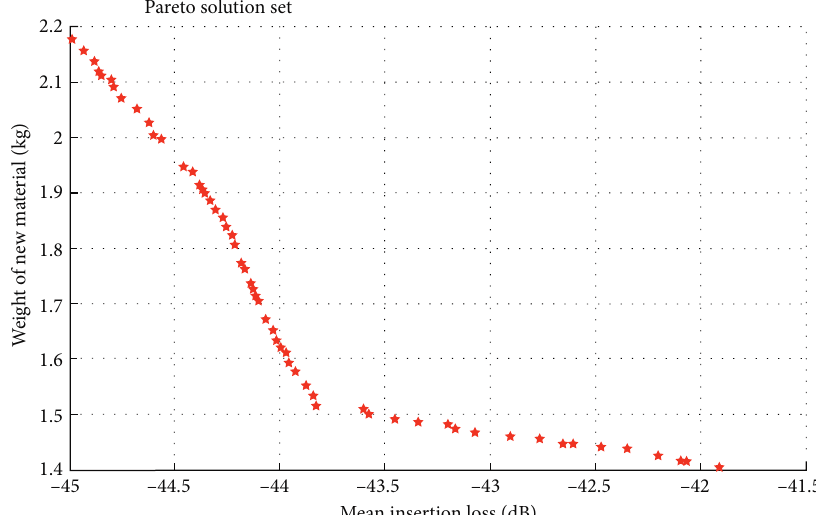
Figure 15: Pareto solution set between average insertion loss and total